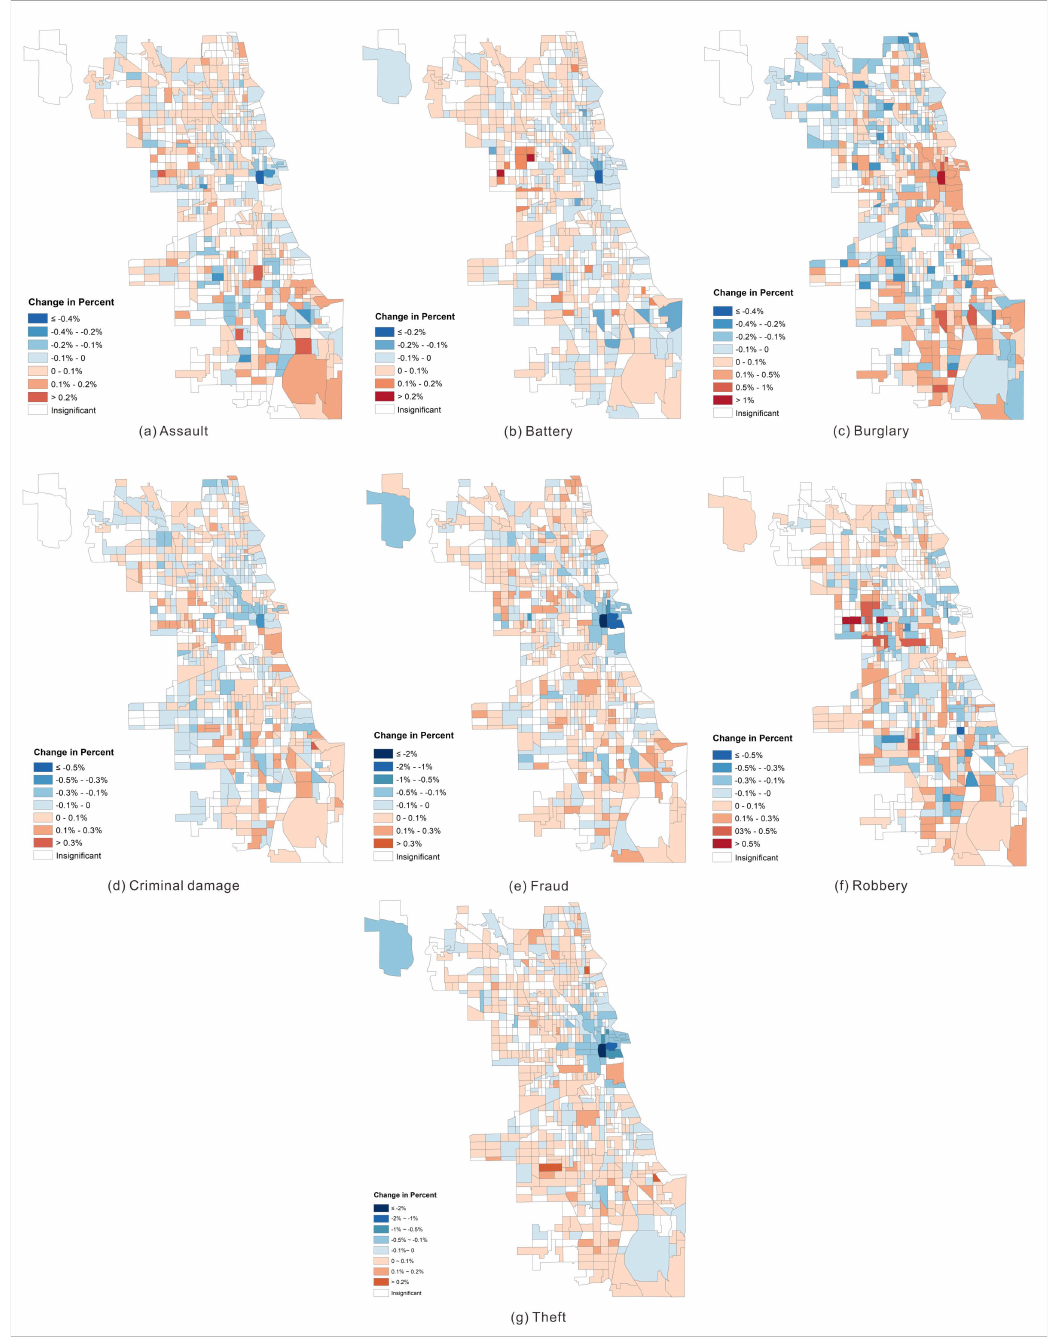
Figure 6. Differences in the percentages between 2020 and 2019 of different crimes’ spatial distributions based on the spatial unit when spatial point pattern test (SPPT) results are significant. Blue symbols indicate when the percentage for 2020 is significantly less than for 2019, and red indicates when the percentage is significantly